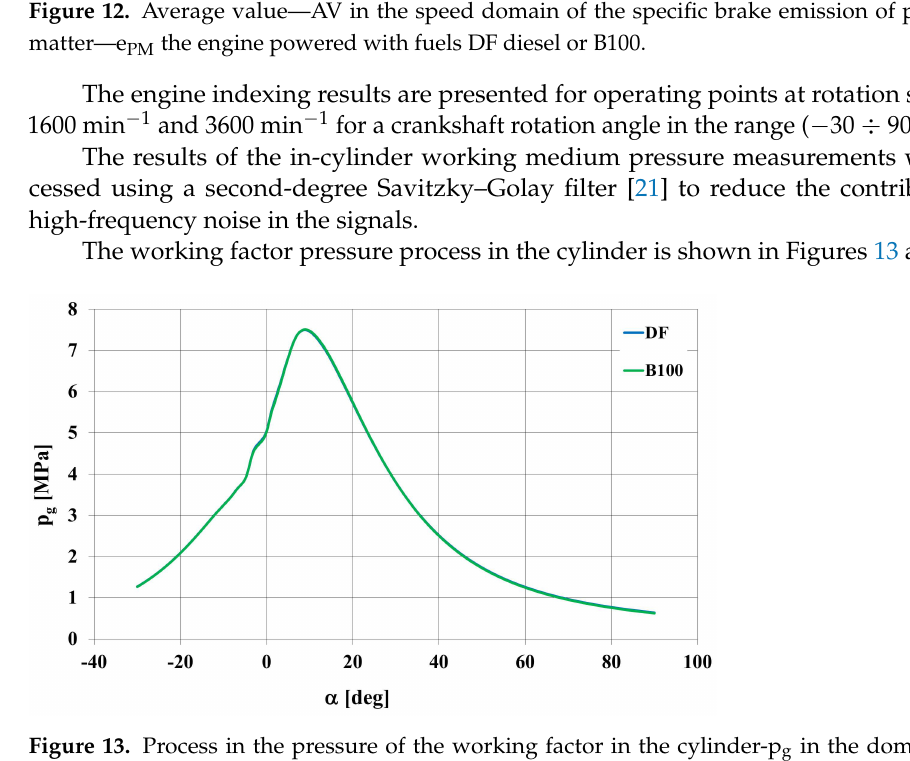
Figure 13. Process in the pressure of the working factor in the cylinder-p g in the domain of the crankshaft rotation angle- α at the rotation speed of 1600 min − 1 for the engine powered with fuels DF diesel or